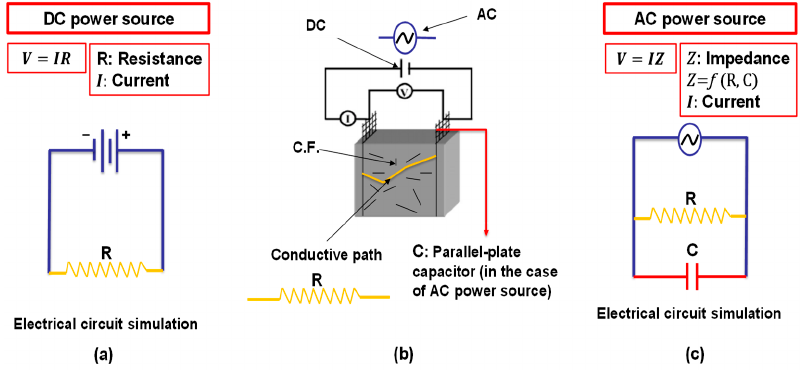
Figure 4. The effect of DC and AC on the electrical resistance measurement of the cement-based sensors: ( a ) DC power source; ( b ) conductive path simulation; ( c ) AC power